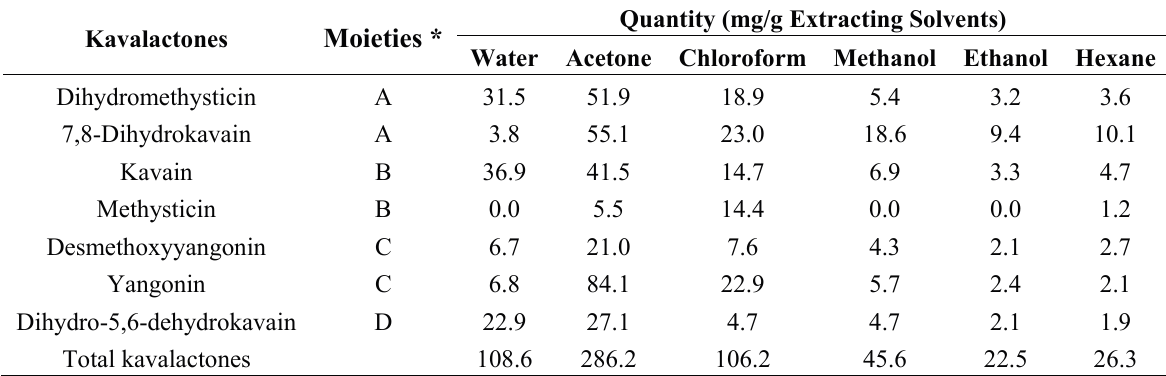
Table 4. Content of DDK and other major kavalactones in different extracting solvents prepared from kava roots (mg/g extract) [9]. * Structure of kavalactones divided by types A–D